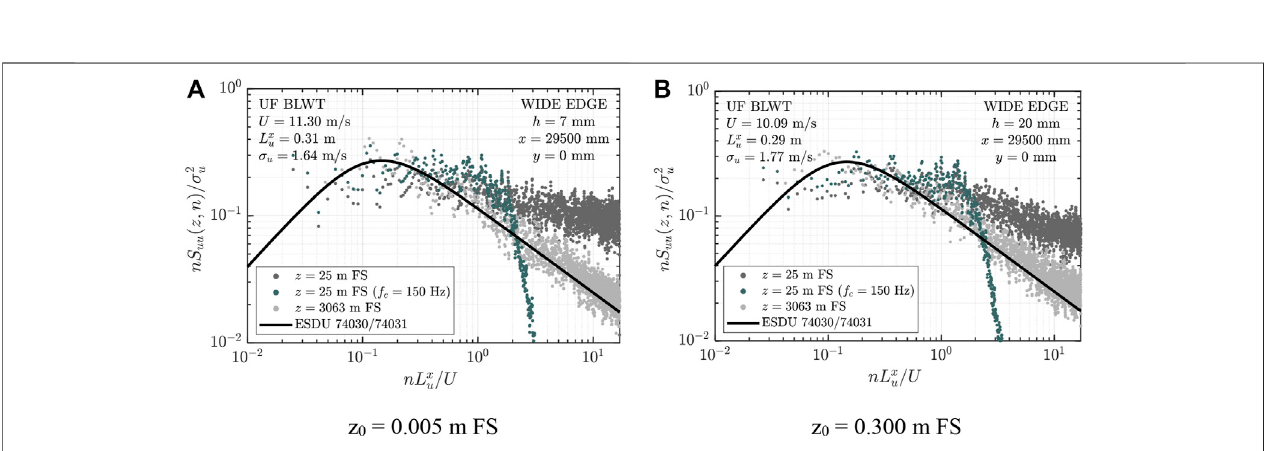
FIGURE 6 | Longitudinal power spectra. (A) z 0 = 0.005 m FS. (B) z 0 = 0.300 m FS.